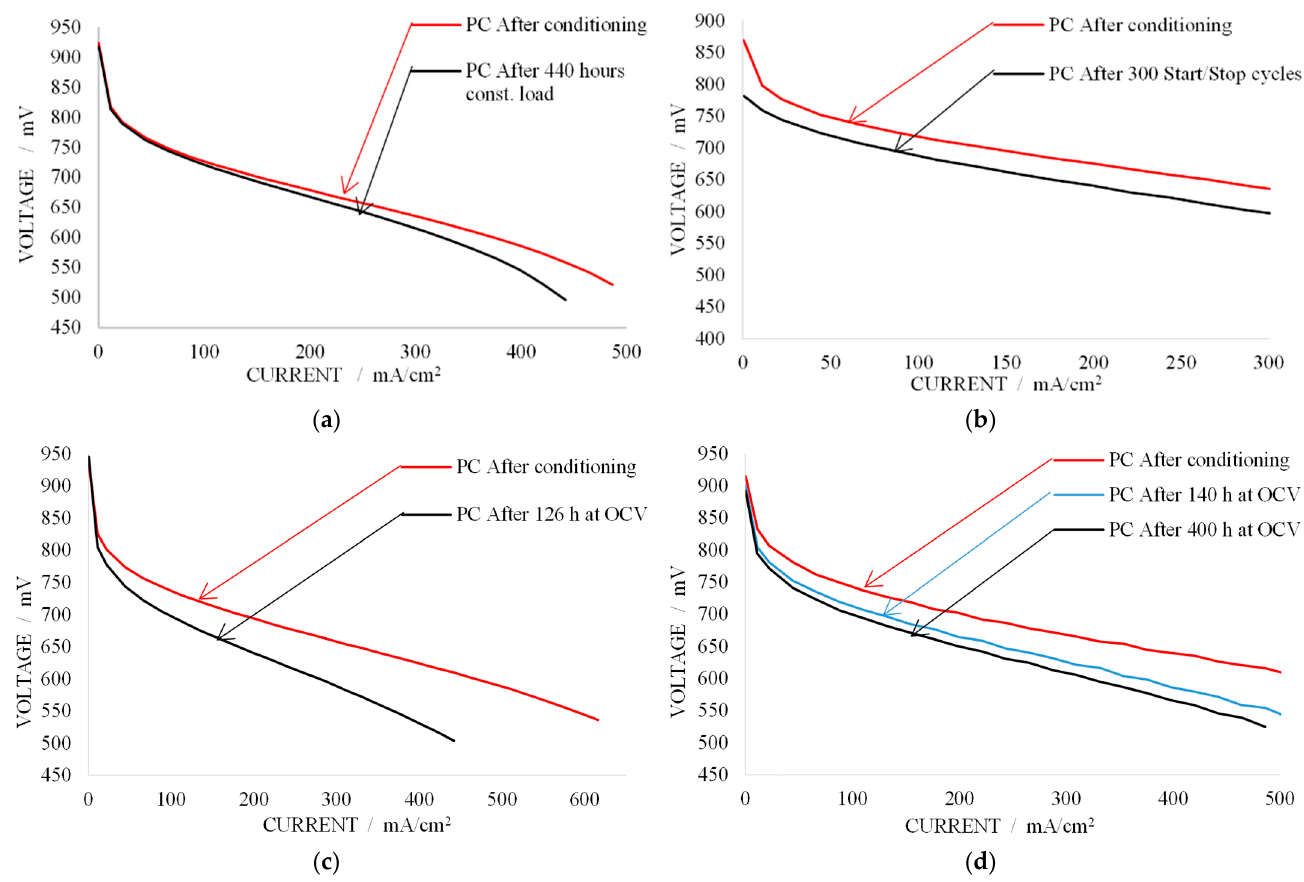
Figure 3. Polarization curves (PCs) of ( a ) MEA CL_1, ( b ) MEA SS_2, ( c ) MEA OCV_1, ( d ) MEA OCV_2. MEA SS_2 was subjected to 300 start-stop cycles. The degradation rate at 0.22 mA/cm 2 of MEA SS_2 was 81 μ V/h. It is noticeable from Figure 3b that this operation condition